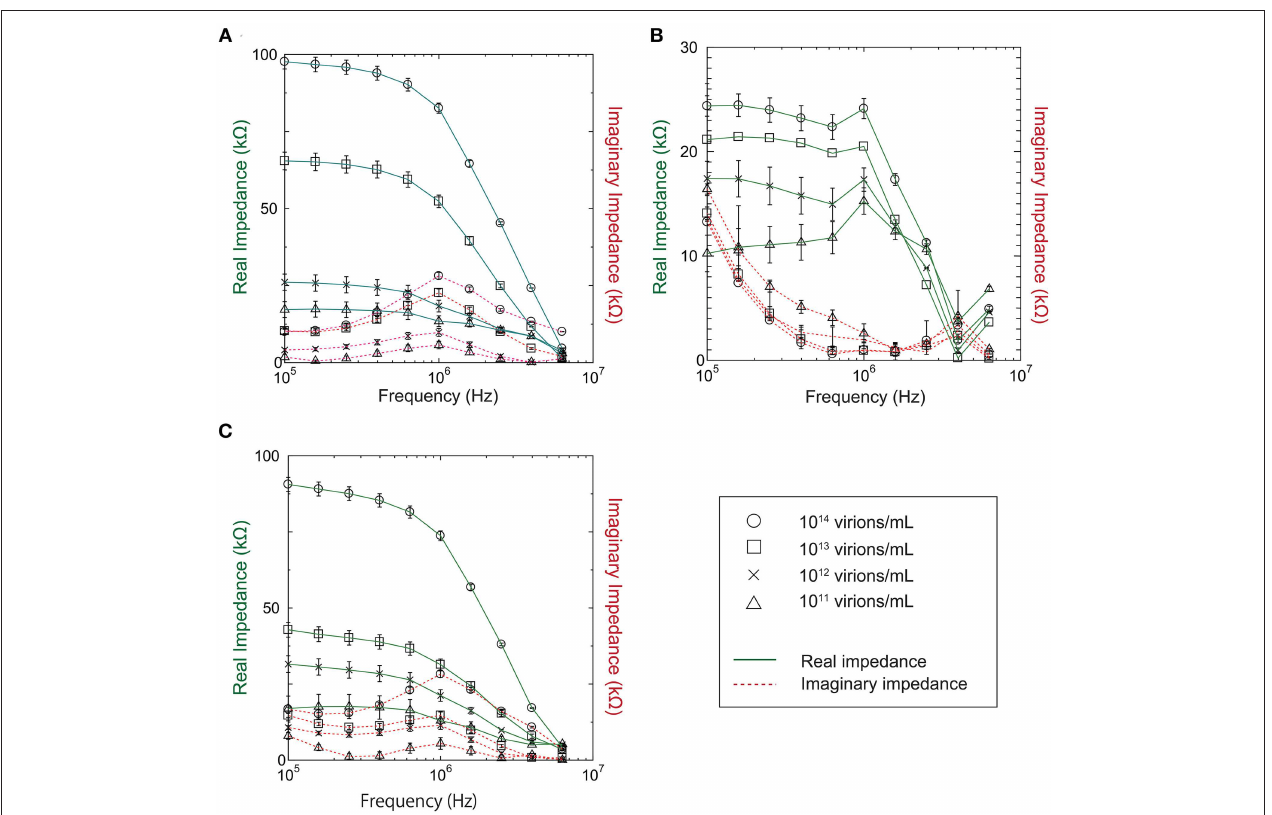
FIGURE 4 | Real and imaginary components of measured impedance for (A) Baculovirus, (B) TMV, and (C) Influenza virus.